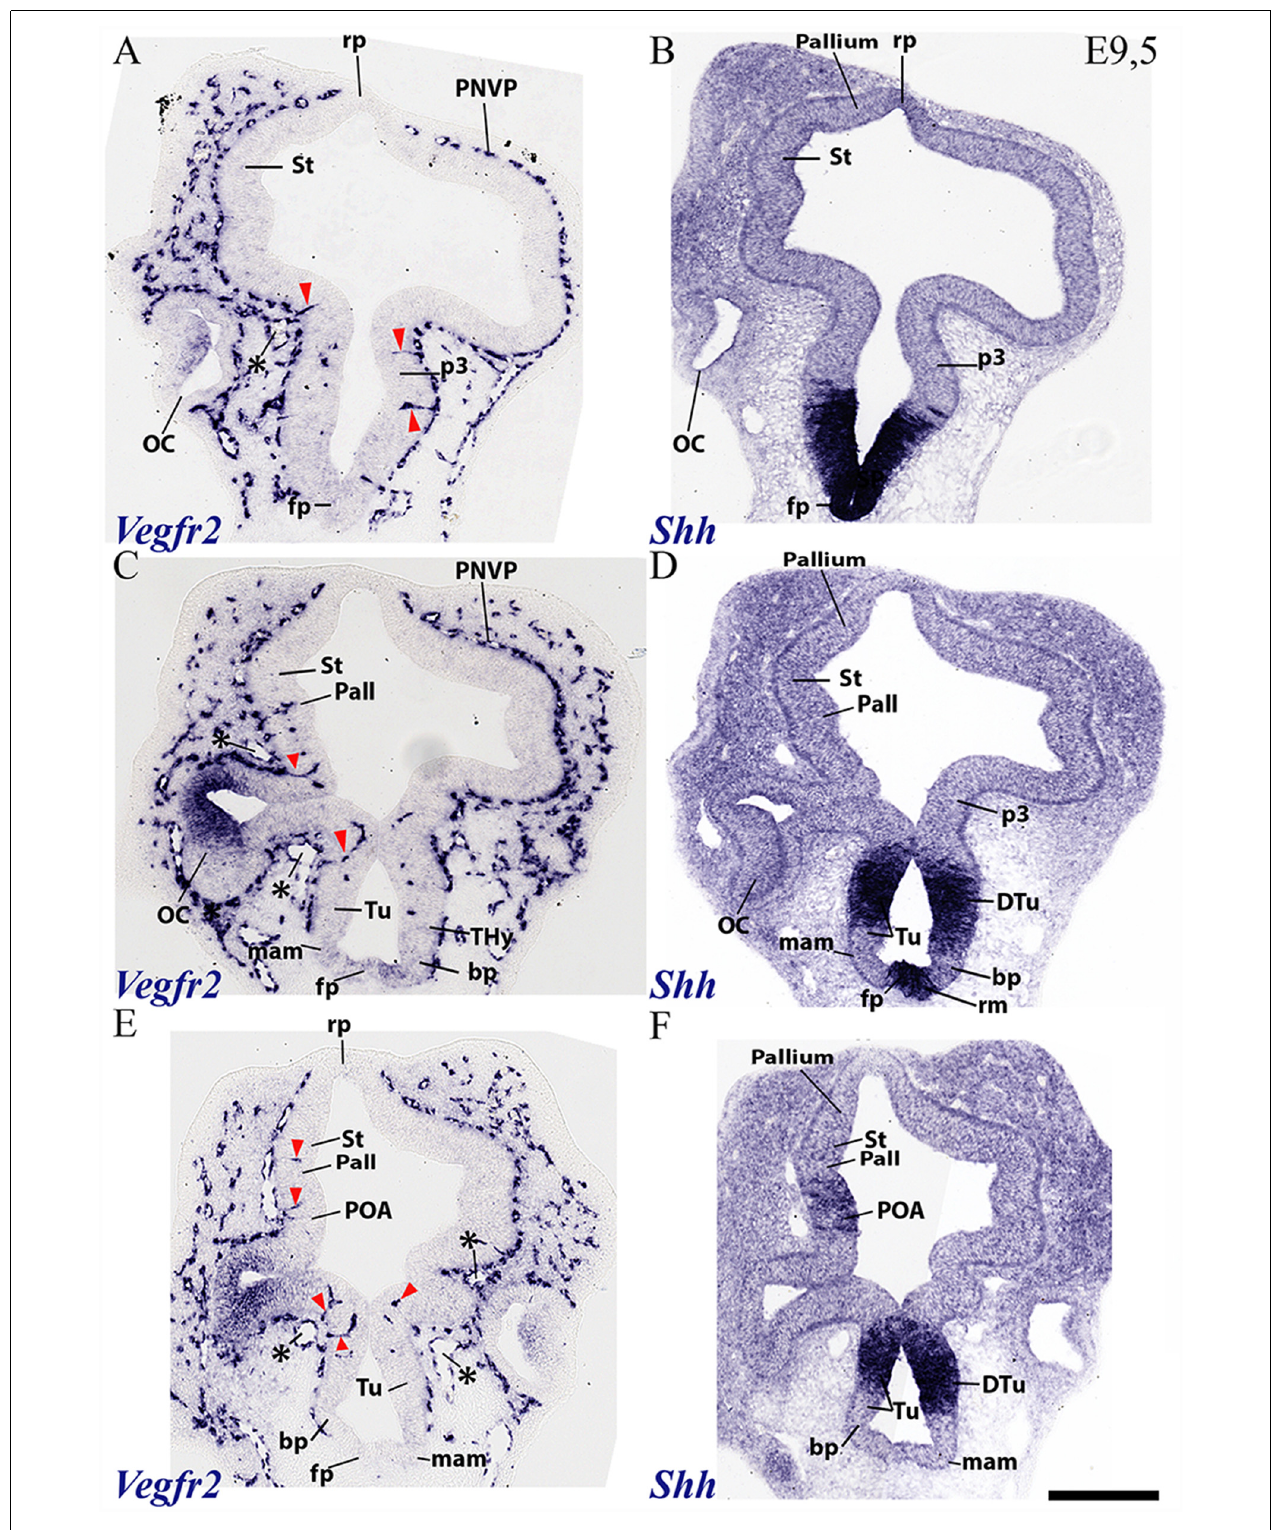
FIGURE 4 | Horizontal sections through a mouse secondary prosencephalon and diencephalon at E9.5 showing PNVP vascularization and first perforant vessels (Vegfr2; A,C,E ), compared in consecutive sections with a marker of hypothalamic and diencephalic basal plate (Shh; B,D,F ). See schematic representation of plane of section in Figure 3H . See description in the text. Red arrow heads: perforant vessels. Asterisks: presumed venous sinuses. Scale bar: 250 µ m.